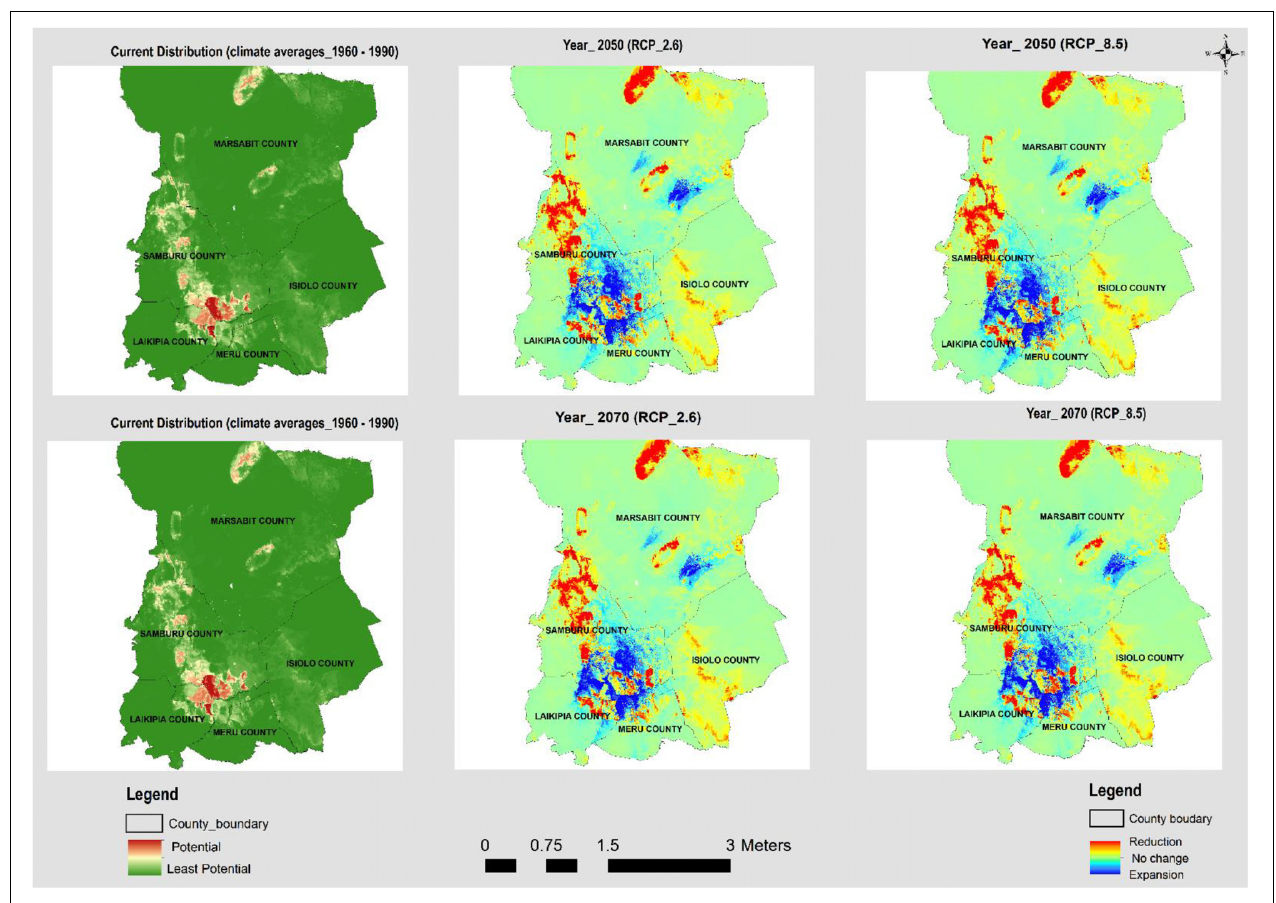
FIGURE 2 | The current and potential distribution under RCP 2.6 and RCP 8.5 for the years 2050 and 2070 for A.